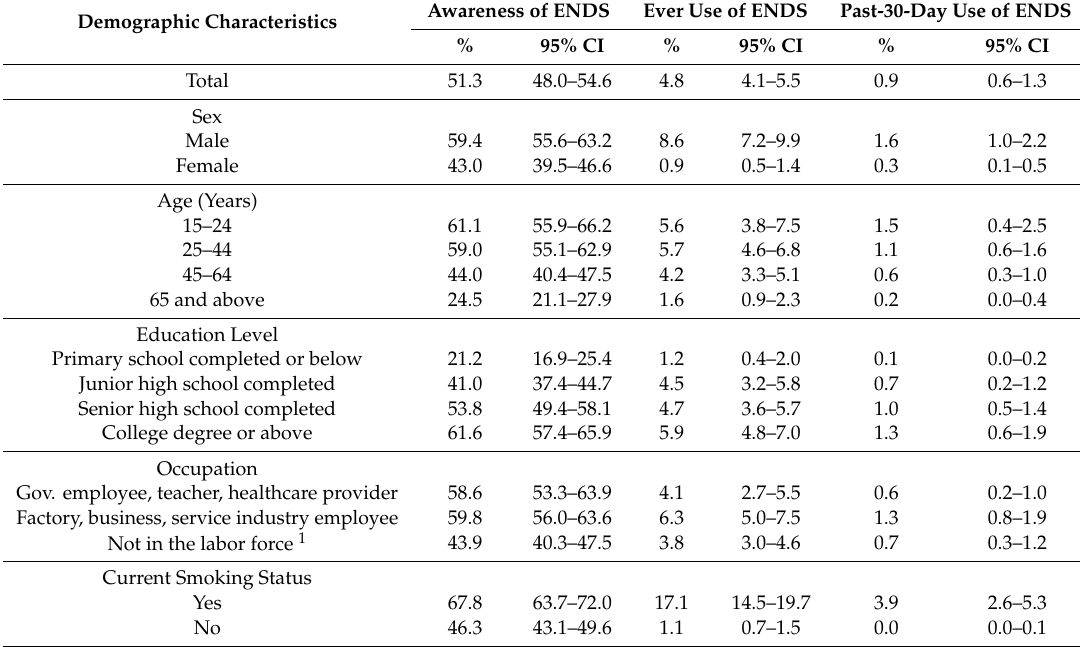
1 Respondents who were not in the labor force included students, homemakers, retired, and unemployed residents either able or unable to